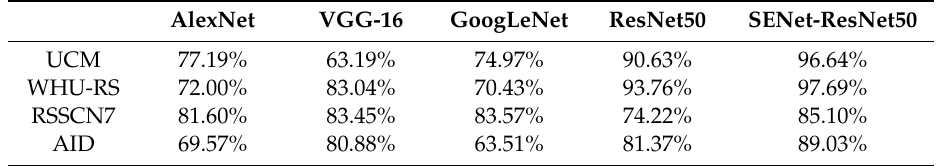
Table 2. Performance comparison of mean Average Precision (mAP) with di ff erent CNN backbone networks.